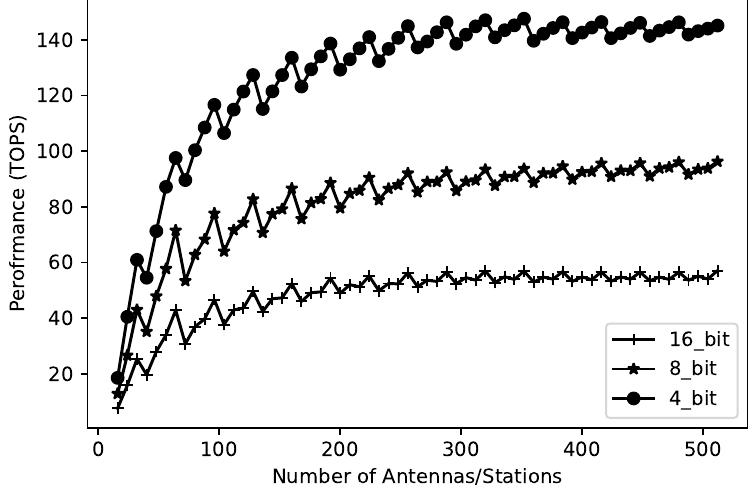
Figure 5. Performance of TCC on an A5000 GPU. The sawtooth shapes are caused by work distri- bution imbalances and redundant computations for non-multiples of 48 or 64 antennas/stations [7]. For smaller numbers of antennas or stations, the TCC is memory-I/O-bound, so it cannot achieve peak performance. For larger numbers of stations, the TCC converges to a plateau as it becomes compute-bound, even though the memory bandwidth use remains high. The GPU is eventually limited by the power use, as the driver slows down the clock to keep the GPU within its power